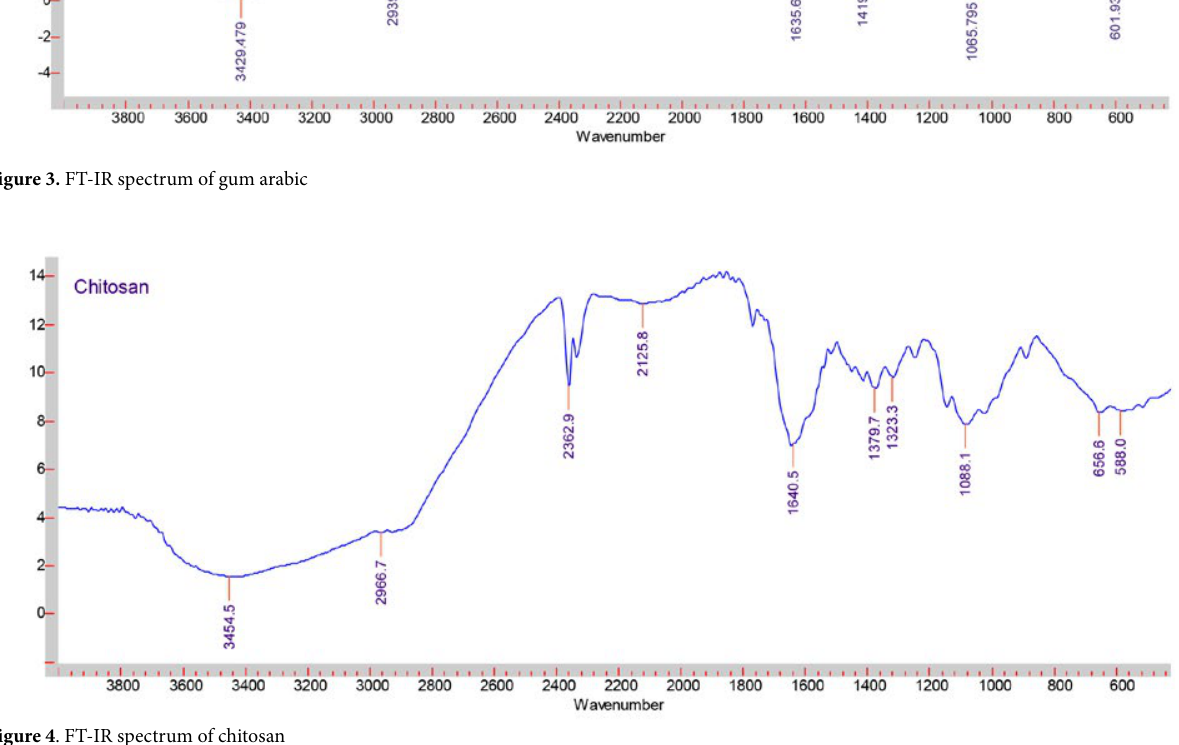
Figure 4 . FT-IR spectrum of chitosan